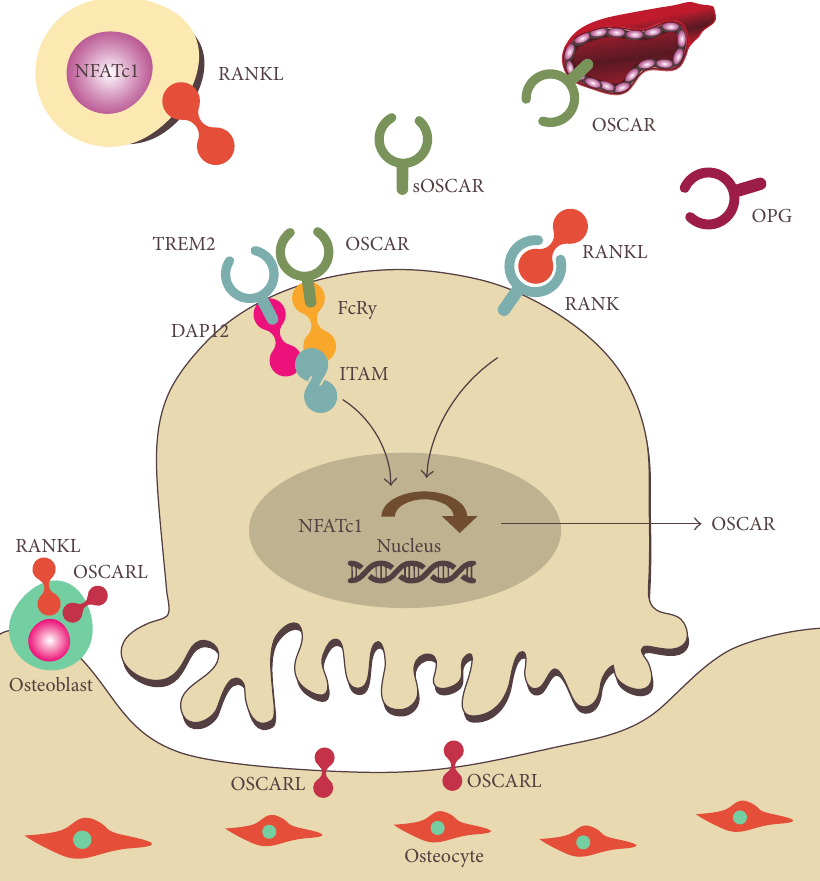
Figure 1: RANGL-RANK-OPG axis and ITAM, the costimulatory pathway, in inflammation induced localised bone loss pathologies.